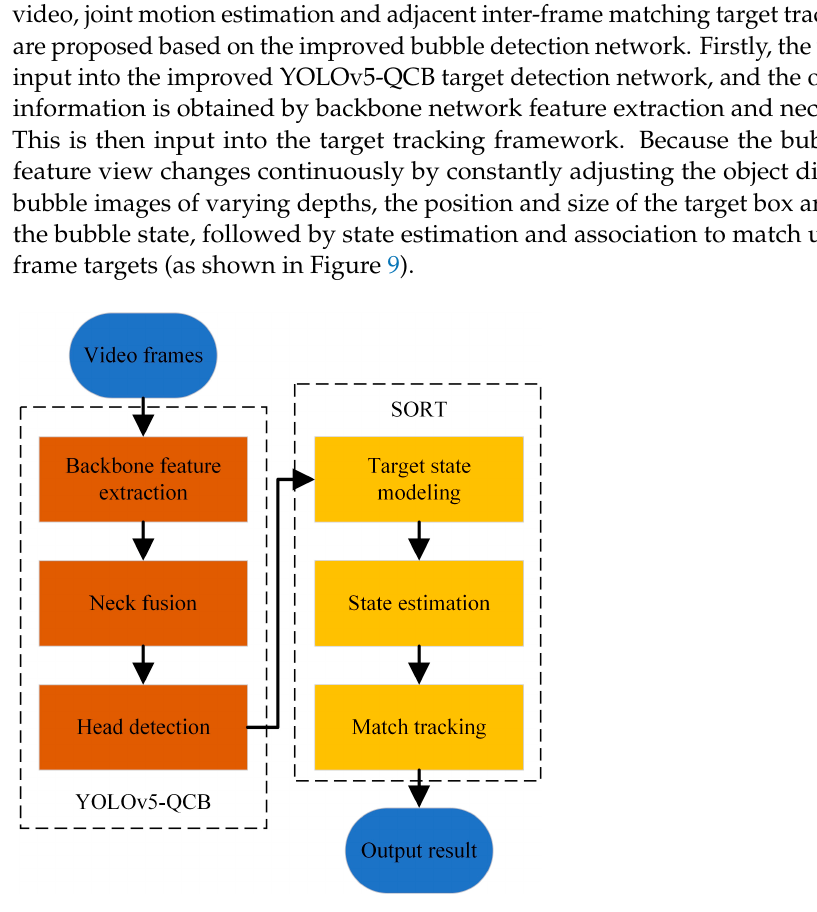
Figure 9. Flow chart of the tracking algorithm.